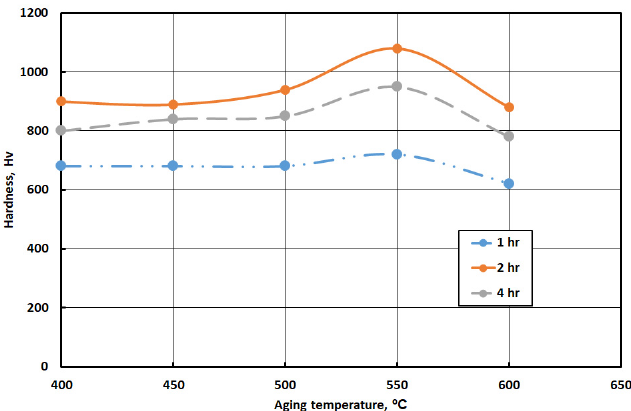
Figure 3. HV for maraging steel (M9.8) under investigation at different aging temperatures and at different times.